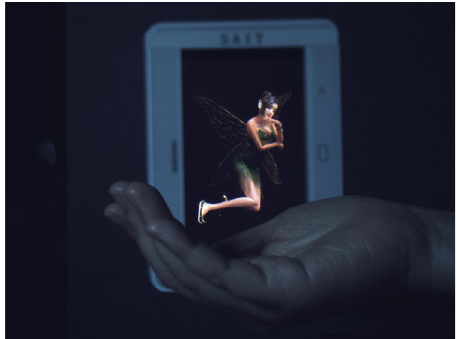
Fig. 1 A photo of a holographic image taken with a real hand. The holographic image and the human hand are at the same distance from the camera. It provides natural depth perception and prompts a viewer to focus on the object itself, not on the screen. The bulk-optic backlight unit is used to demonstrate the ultimate quality of the holographic image. The movie clip is available in Supplementary Movie